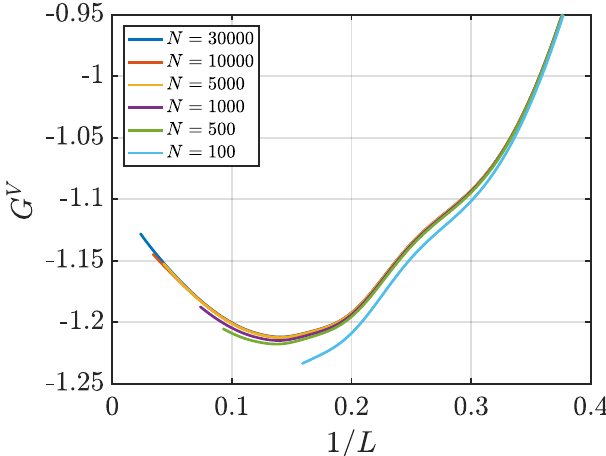
Figure 6. KB integrals of finite spherical subvolumes G V (Equation (4)) vs. 1/ L ( L is the diameter) for the LJ fluid at T = 2 and ρ = 0.4 (dimensionless units). The values of G V are computed for systems with varying number of molecules N . The used RDFs are provided in Figure